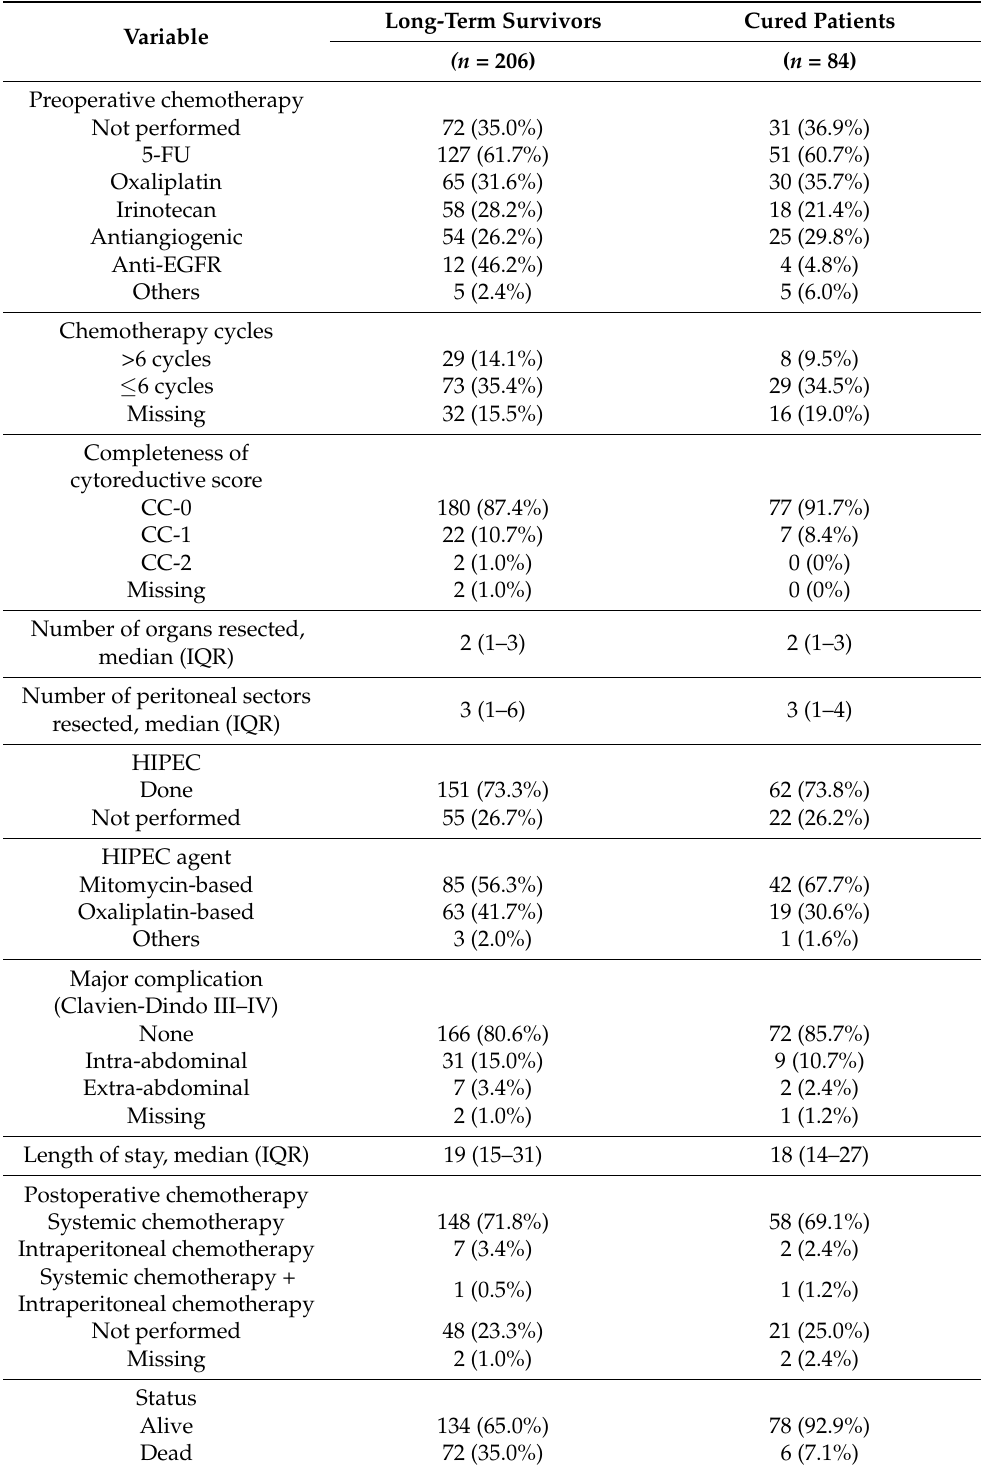
Table 2. Treatment